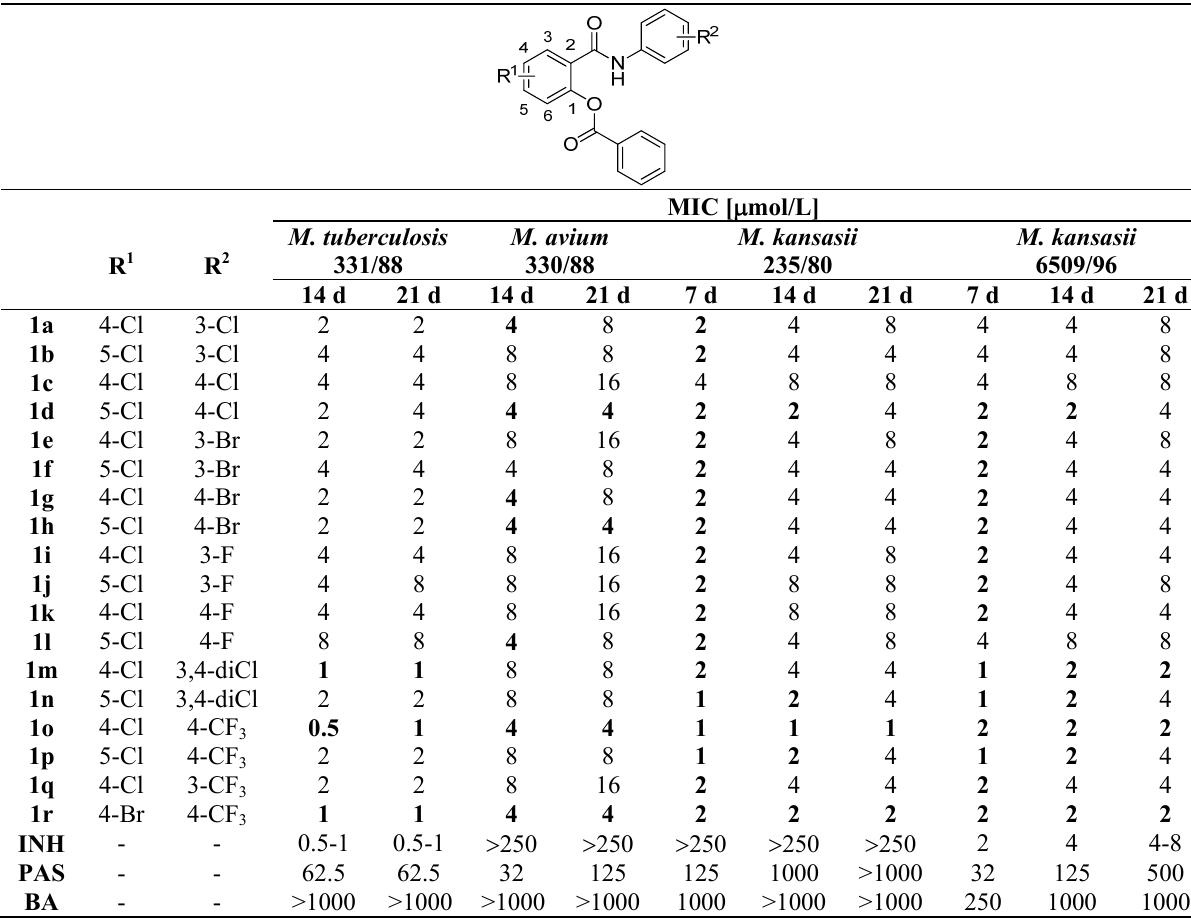
Table 1. Antimycobacterial activity of salicylanilide benzoates 1